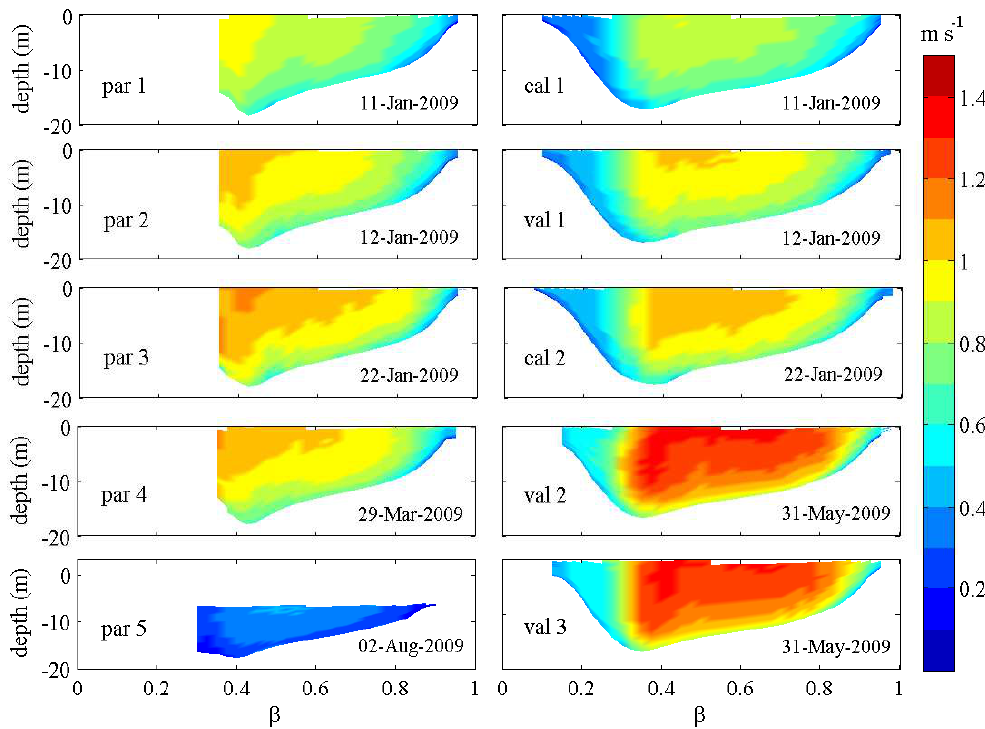
Fig. 4. Streamwise velocity spatial structure over the cross-section during boat-mounted ADCP surveys. Transects labelled “par” were taken in front of the H-ADCP to obtain hydraulic parameters, while the ones labelled “cal” and “val” were taken 20m upstream to cover the whole channel width for calibration and